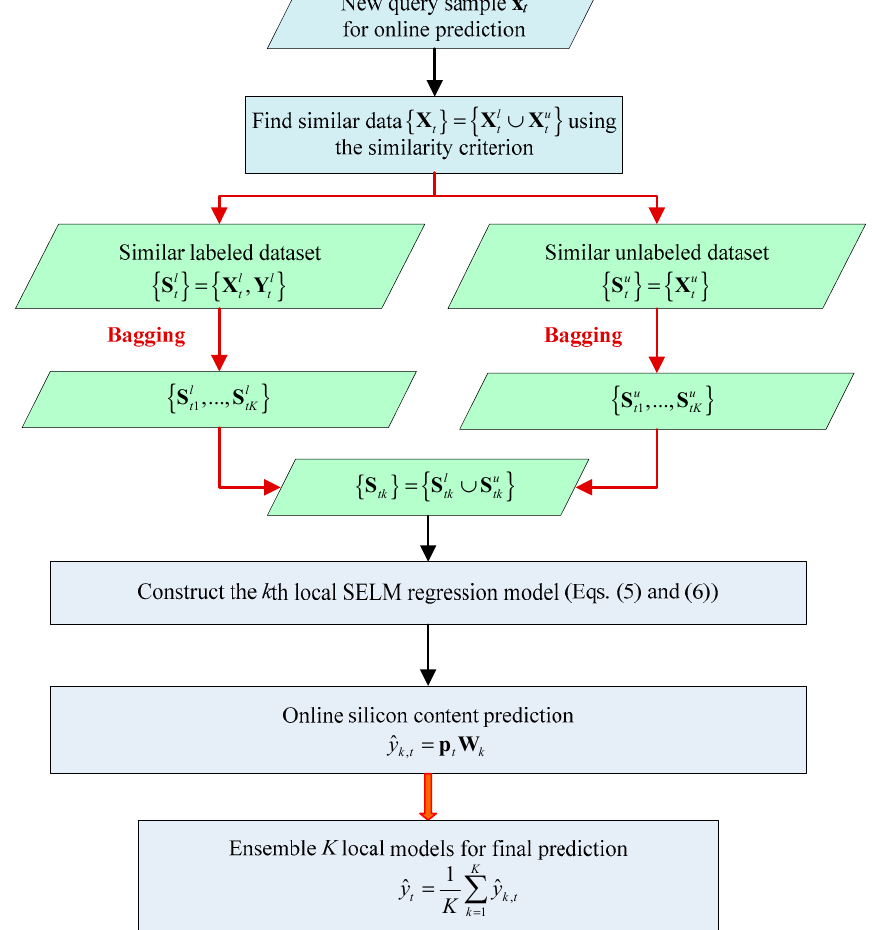
Figure 1. Bagging local semi-supervised models (BLSM)-based online soft sensing flowchart for the silicon content prediction.